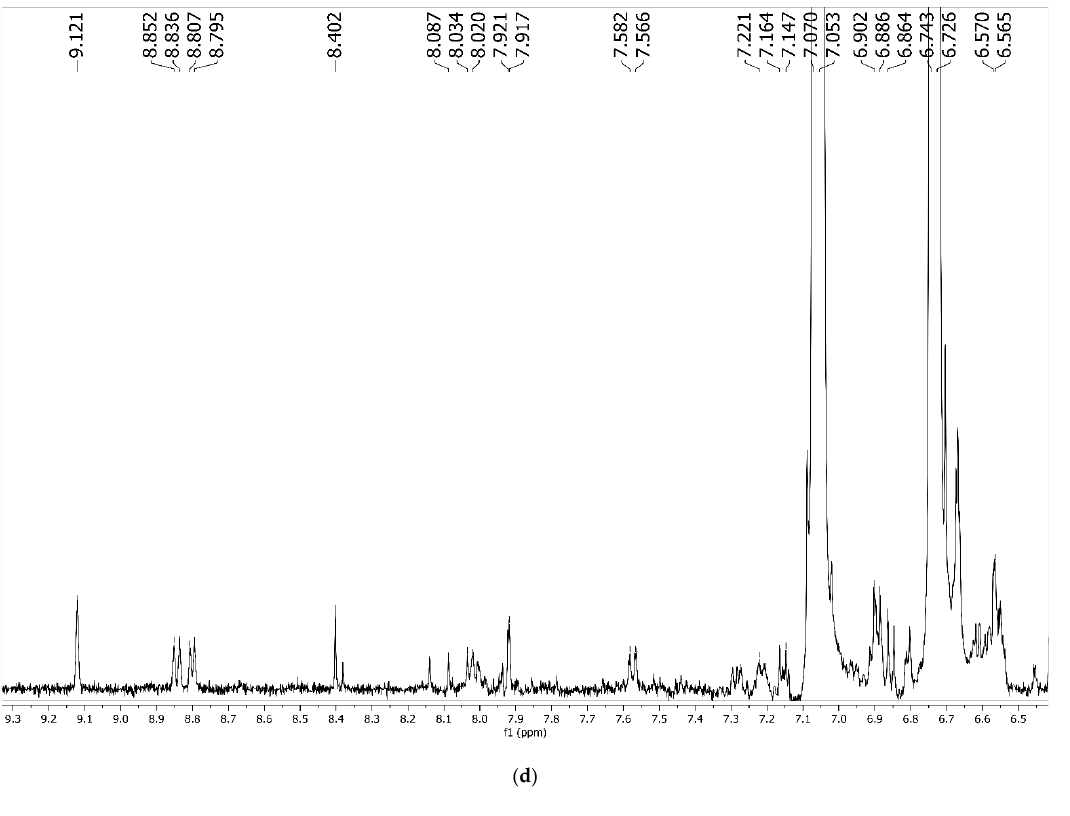
Figure 3. 1 H NMR spectrum of MF ( a ), 1 H NMR spectrum expansion in the region of 2.5-0.6 ppm of MF ( b ), 1 H NMR spectrum expansion in the region of 5.3-3.0 ppm of MF ( c ) and 1 H NMR spectrum expansion in the region of 8.8-6.0 ppm of MF ( d ).